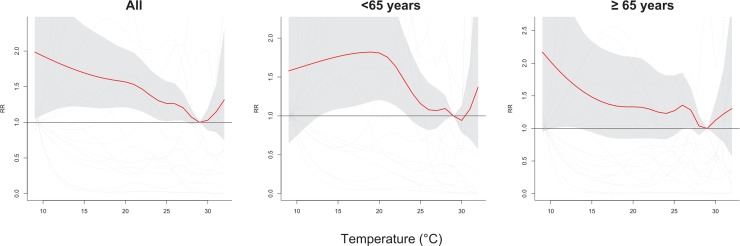
Pooled cumulative 6-day relative risks (RR) of emergency room visit among patients survived with out-of-hospital cardiac arrest in association with daily average temperature for all patients (left), patients younger than 65 years (center), and the elderly (right).